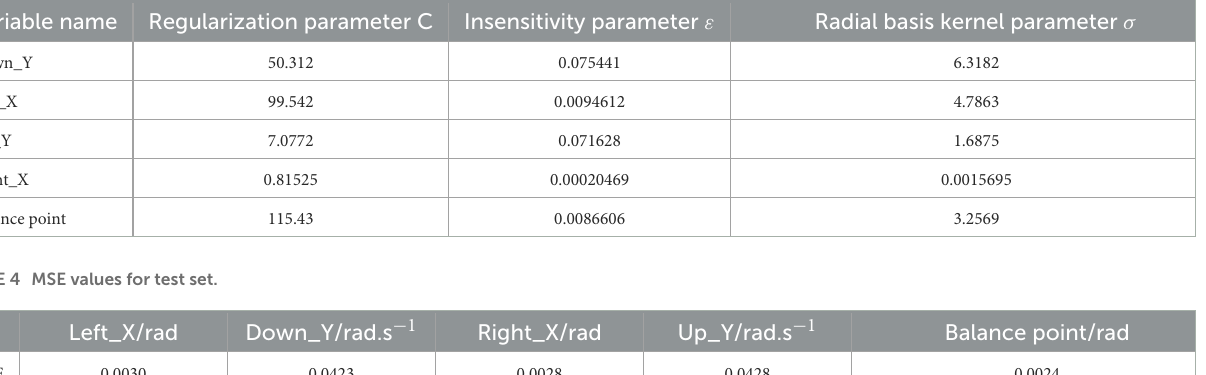
TABLE 3 Optimal SVR parameters.